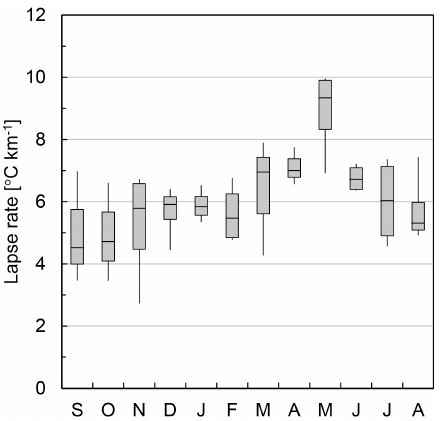
Figure 9. Inter-annual variability between 2009–2013 of the monthly-mean lapse rates based on air temperature data from Rih- pojavri (502ma.s.l.) and Signaldalen (65ma.s.l.). Boxes show the interquartile range of the month’s lapse rate, horizontal lines inside the boxes show the median values, and the whiskers show the full range of the data.